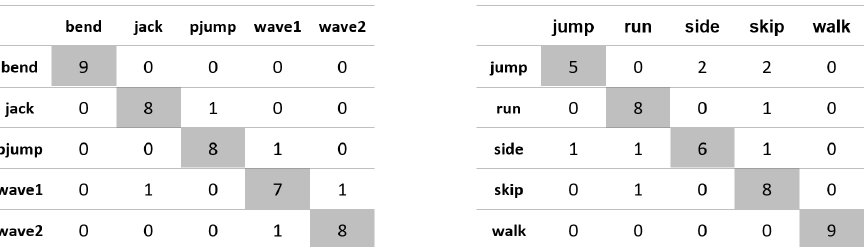
Figure A28. Confusion matrices for the experiment using the ‘upper-occlusion’ database, rectangu- larity and C1 correlation.